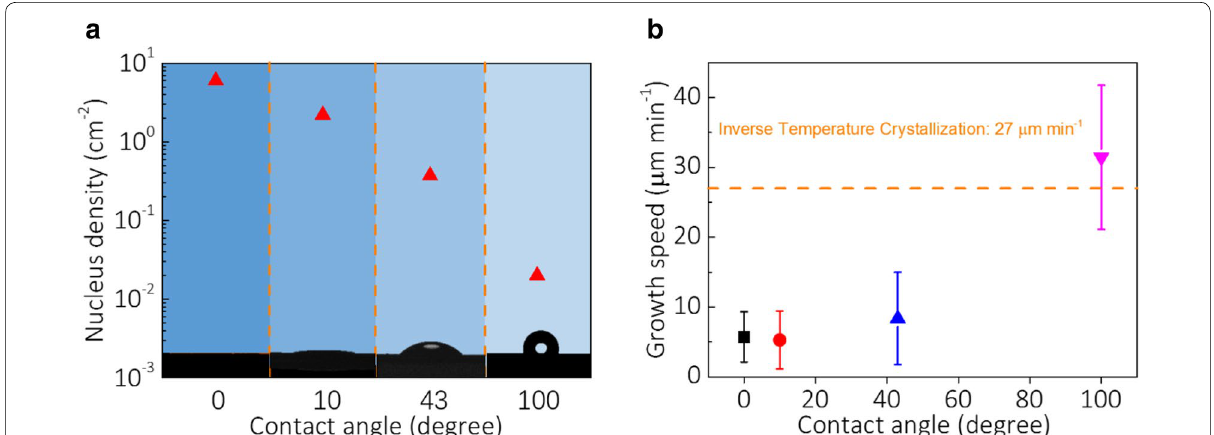
Fig. 2 Influences on the SC‑TF growth by surface engineering of substrates. a The measured nucleus densities on the substrates with different solvent contact angles resulted by different surface treatment conditions. b Growth rates of perovskite single‑crystalline thin films on these